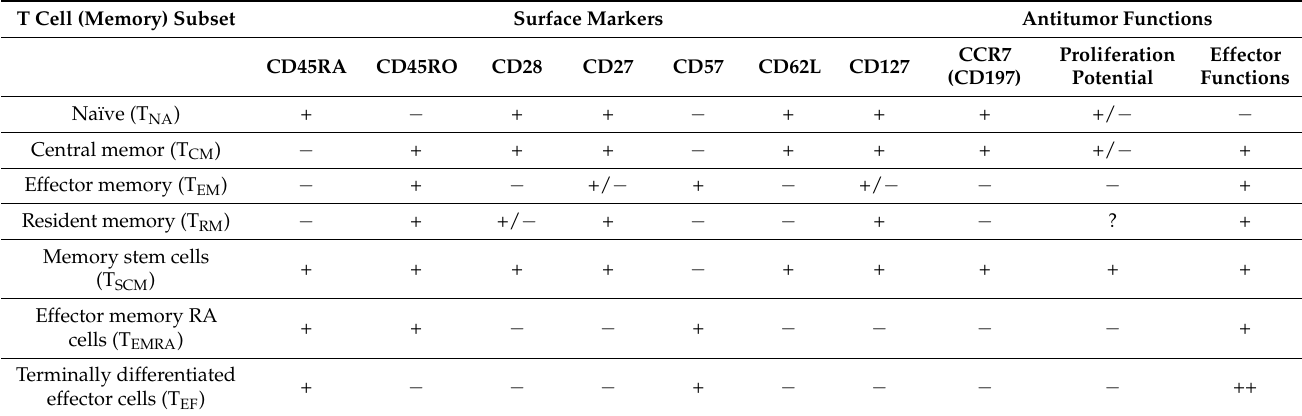
Table 1. T cell subsets and their antitumor capacity. The surface markers that discriminate the different subsets, as well as the proliferation capacity and the effector functions of each population are given [143–145,149]. T Cell (Memory)